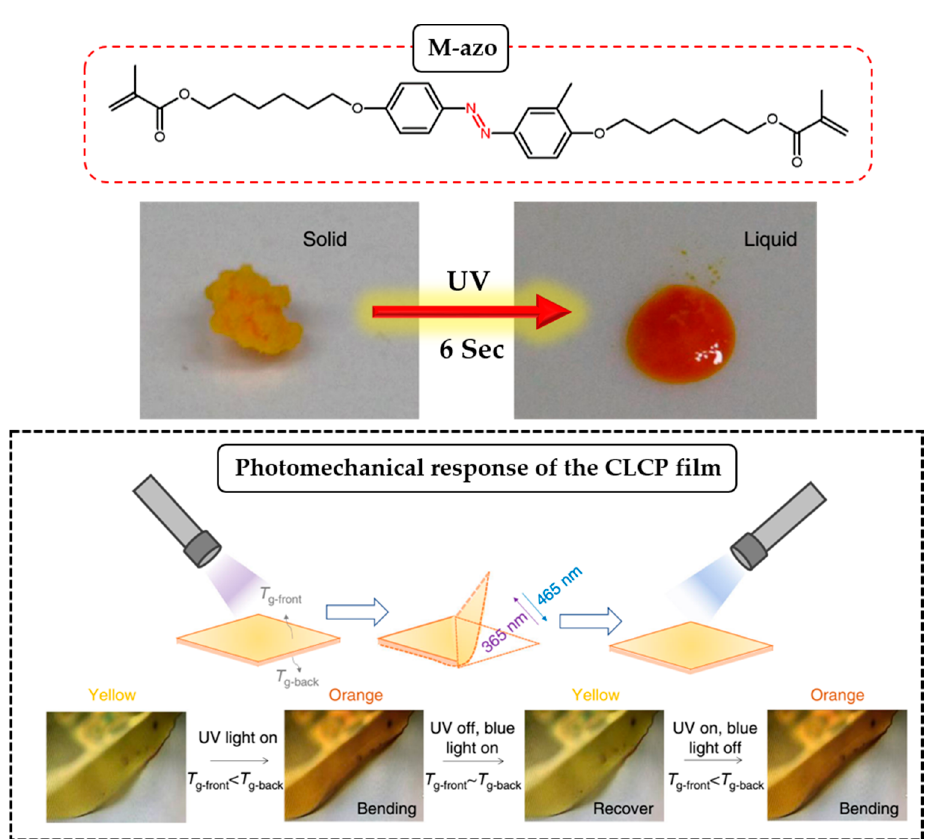
Figure 7. Schematic illustration, snapshots of photomelting process of meta -methylazobenzene (M-azo) compound and photomechanical response of the crosslinked liquid crystalline polymer (CLCP) film developed by Yue et al., Adapted with permission from [47], Springer Nature, 2018.